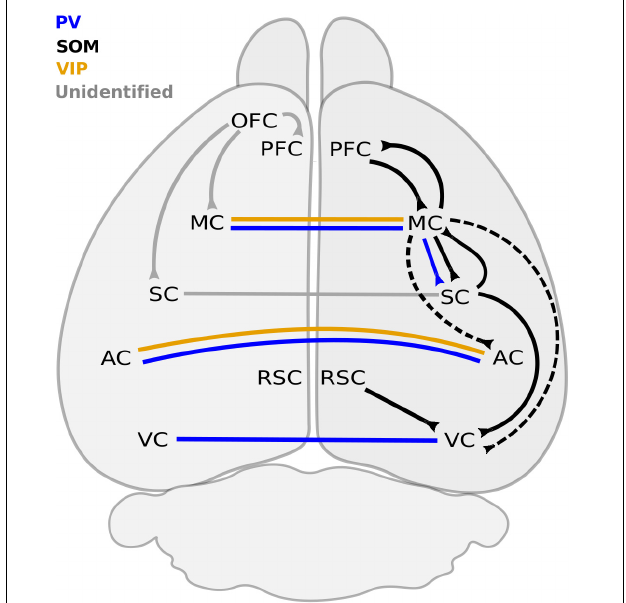
FIGURE 3 | Long-range GABAergic neuron connections between neocortical regions. Ipsilateral connections are mostly dominated by SOM + LRGNs. The PFC sends and receives inhibitory projections from the MC, which also sends inhibitory axons to the SC, AC, and VC. The only reported ipsilateral PV+ connection originates from the MC and terminates in the SC. VC receives SOM + LRGN projections from the MC, SC, and RSC. The molecular identity of LRGNs from the OFC to the PFC, MC and SC remains to be determined. Inhibitory connections between contralateral ACs are PV+ and VIP+, whereas contralateral projections between VCs are PV+ only. The molecular identity of contralateral LRGNs between SCs is unknown. AC, auditory cortex; MC, motor cortex; OFC, orbitofrontal cortex; PFC, prefrontal cortex; RSC, retrosplenial cortex; SC, somatosensory cortex; STR, striatum; VC, visual cortex; PV, parvalbumin; SOM, somatostatin; VIP, vasoactive intestinal peptide. Dashed line refers to connections that remains to be